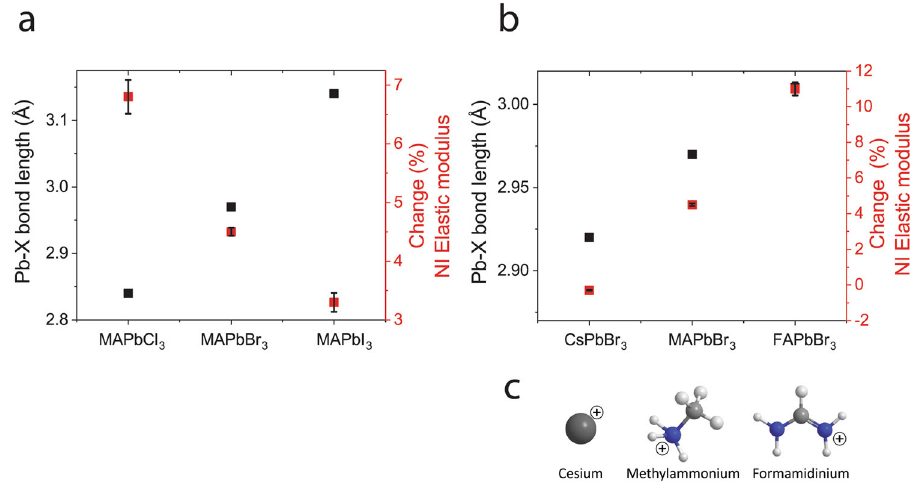
Fig. 4 Humidity dependence of of NI elastic modulus on Pb-X bond length and H-bonding. Pb-X bond length (black) and % change in NI elastic modulus between dry and humid states (red) ( a ) plotted for the series of X anions and ( b ) for the series with different A cations. Error bars are computed from the relative error of the quotient, using standard deviation of individual values. ( c ) scheme showing potential for H-bonding for the different cations, in terms of H atoms (white spheres), available to participate in the bonding; dark grey sphere: Cs; blue sphere: N; light grey sphere: